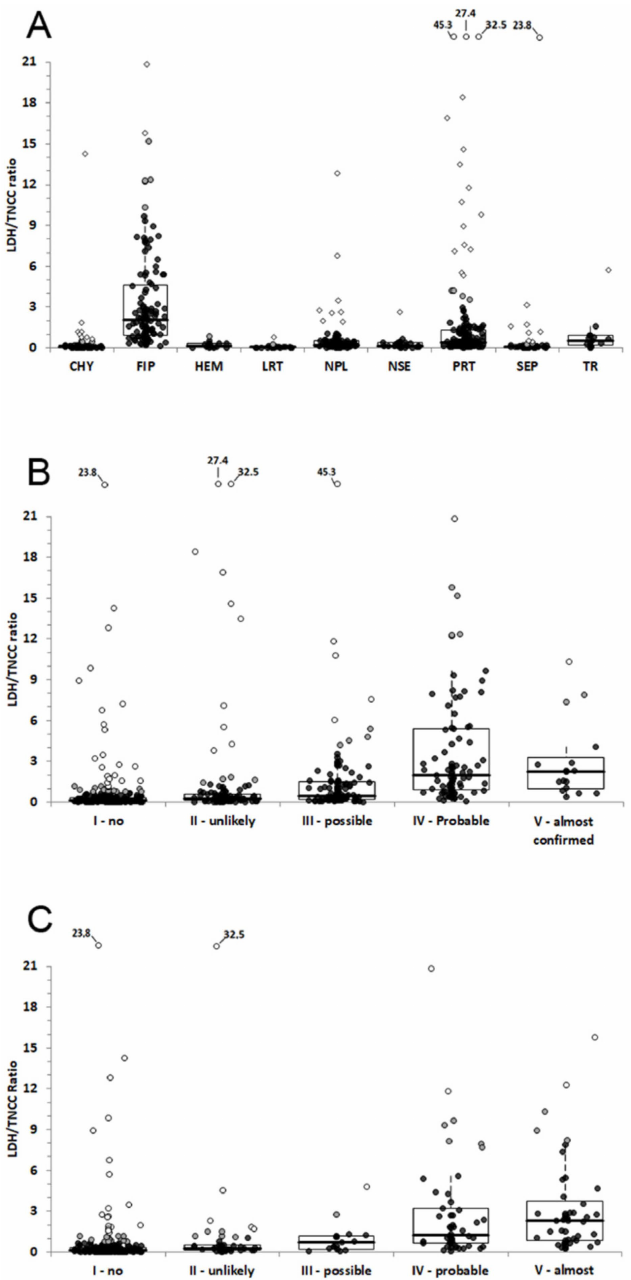
Figure 2. LDH/TNCC ratio recorded in effusions classified based on cytological and physicochemical classification (( A ), step 1), in terms of probability of FIP based on the subjective interpretation of cytological and physicochemical analysis of the effusions (( B ), step 2) or on the cytological and physicochemical analysis of the effusions associated with additional laboratory data (( C ), step 3). The boxes indicate the first to third interquartile range (IQR), the horizontal lines indicate the median value, whiskers extend to further observation within the first quartile minus 1.5 × IQR or to further observation within the third quartile plus 1.5 × IQR. Black dots indicate values not classified as outliers; grey dots indicate the near outliers (values exceeding the third quartile ± (1.5 × IQR)) and white dots the far outliers (values exceeding the third quartile ± (3.0 × IQR). In order to expand the boxes and whiskers, the scale has been limited to a LDH/TNCC ratio of 21, and far outliers that exceeded the limit of the scale have been reported on the top of each graph, with the corresponding point